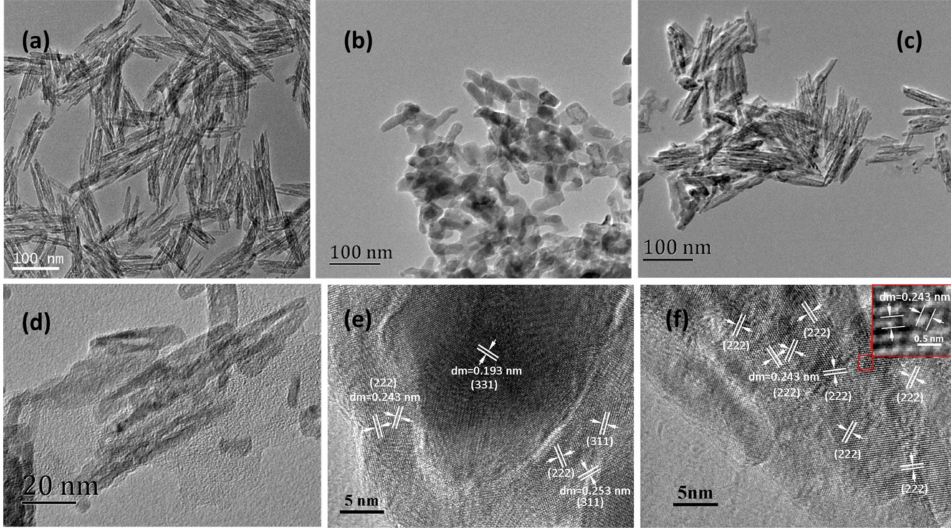
Figure 2. TEM images of ( a ) α -Fe 2 O 3 NPs, ( b ) Fe 3 O 4 -TR, and ( c , d ) Fe 3 O 4 -OVs/NC. High-resolution TEM images of ( e ) Fe 3 O 4 -TR and ( f ) Fe 3 O 4